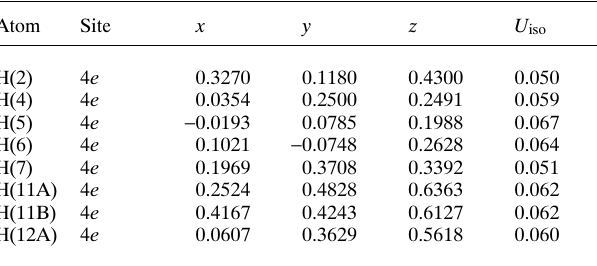
Table 2. Atomic coordinates and displacement parameters (in Å 2 )